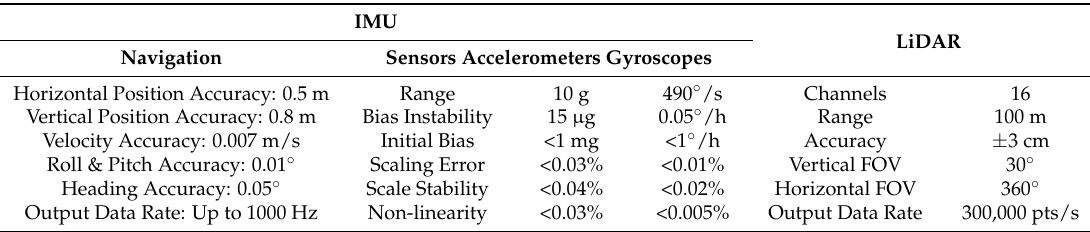
Table 1. The specifications of the IMU and LiDAR.